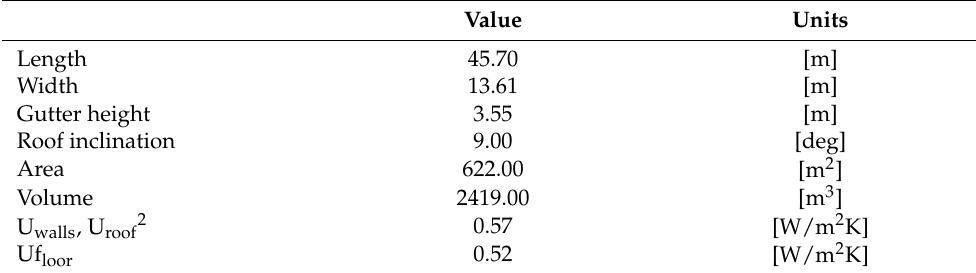
Table 1. Broiler house dimensions and envelope characteristics 1